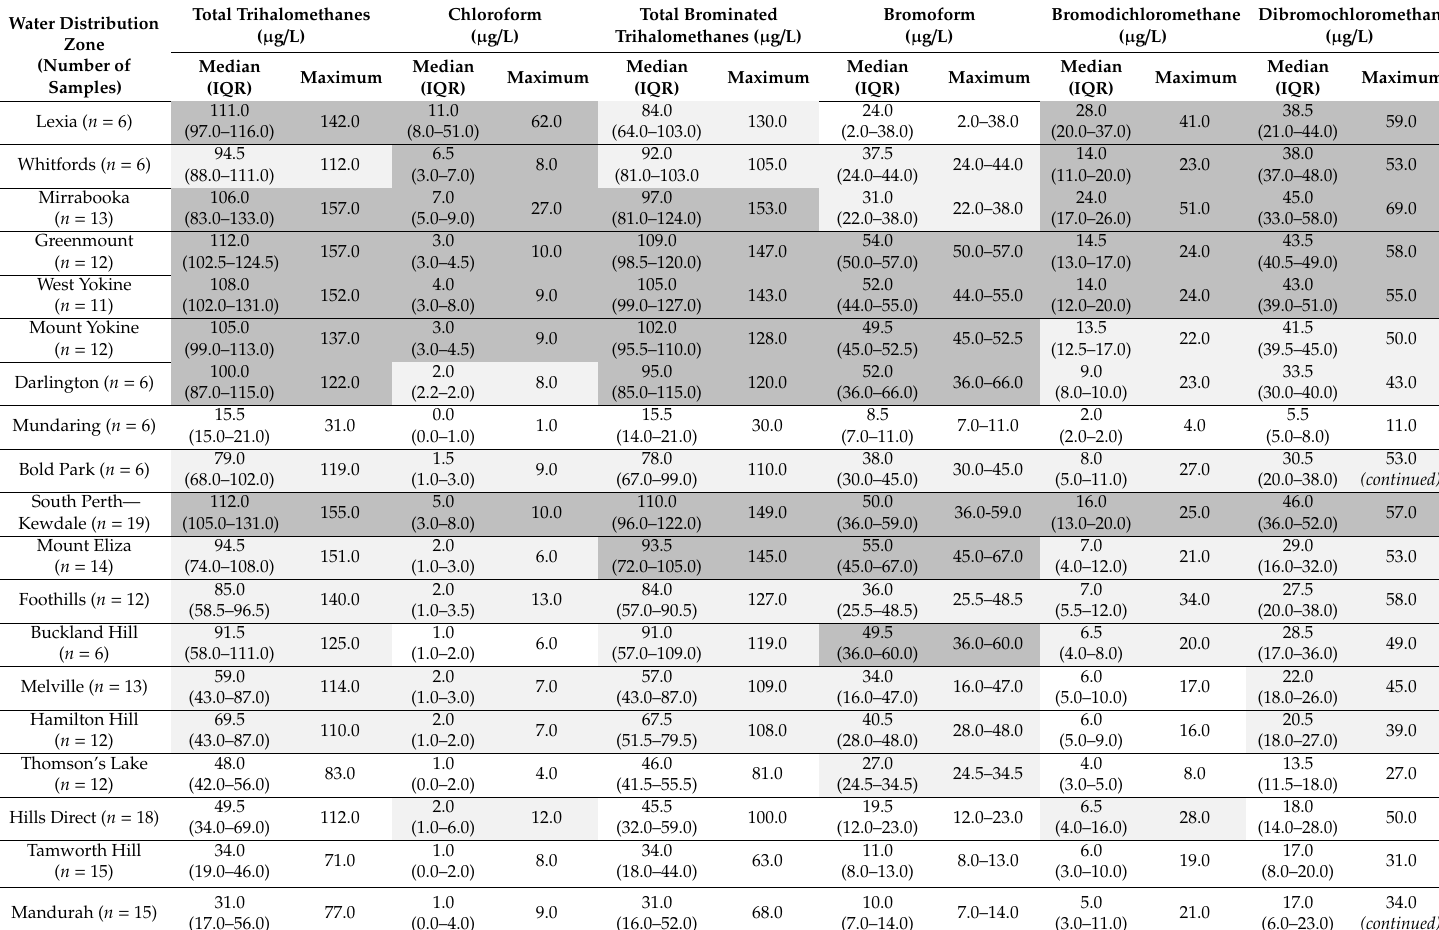
Table 1. Summary of the concentrations ( µ g / L) of total trihalomethanes, total brominated trihalomethanes, and the four species of trihalomethanes across the 21 water distribution zones (ordered from north to